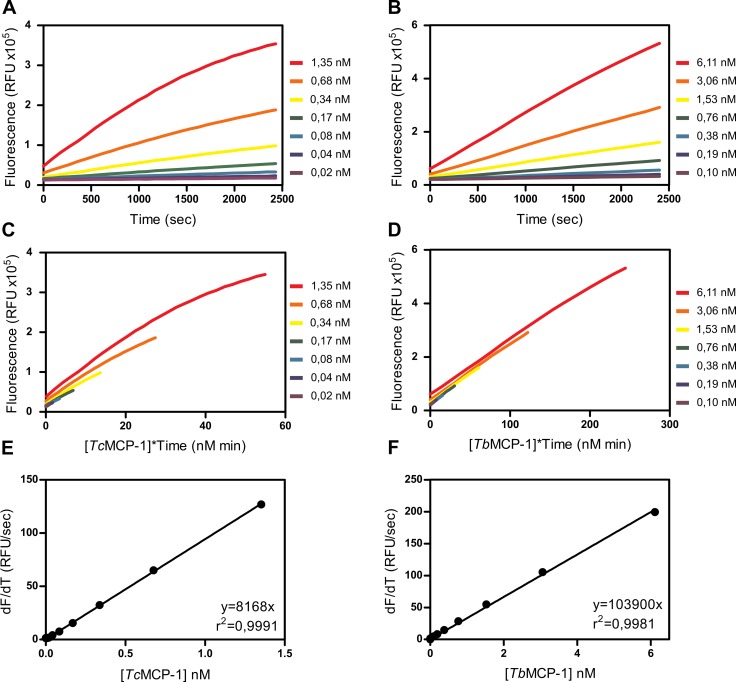
Continuous fluorogenic assays for recombinant MCPs.(A) Kinetic progression curves for different TcMCP-1 concentrations at a fixed Abz-LKFK(Dnp)-OH dose (1,25 μM). (B) The activity of 2-fold dilutions of TbMCP-1 was analyzed with Abz-RFFK(Dnp)-OH as substrate (4,8 μM). For both enzymes, working dilutions were selected from those that showed linear kinetics for more than 40 minutes. (C, D) Selwyn test for different TcMCP-1 and TbMCP-1 concentrations. In both cases, the global fitting of experimental data from different enzyme dilutions to a unique curve was good, indicating that enzymes remained stable during the whole assay. To facilitate observation, curves were slightly displaced from each other in the Y axis. (E, F) Curve of V0 vs. [E]0 for TcMCP-1 and TbMCP-1 respectively. In both cases, the expected linear behavior was observed.